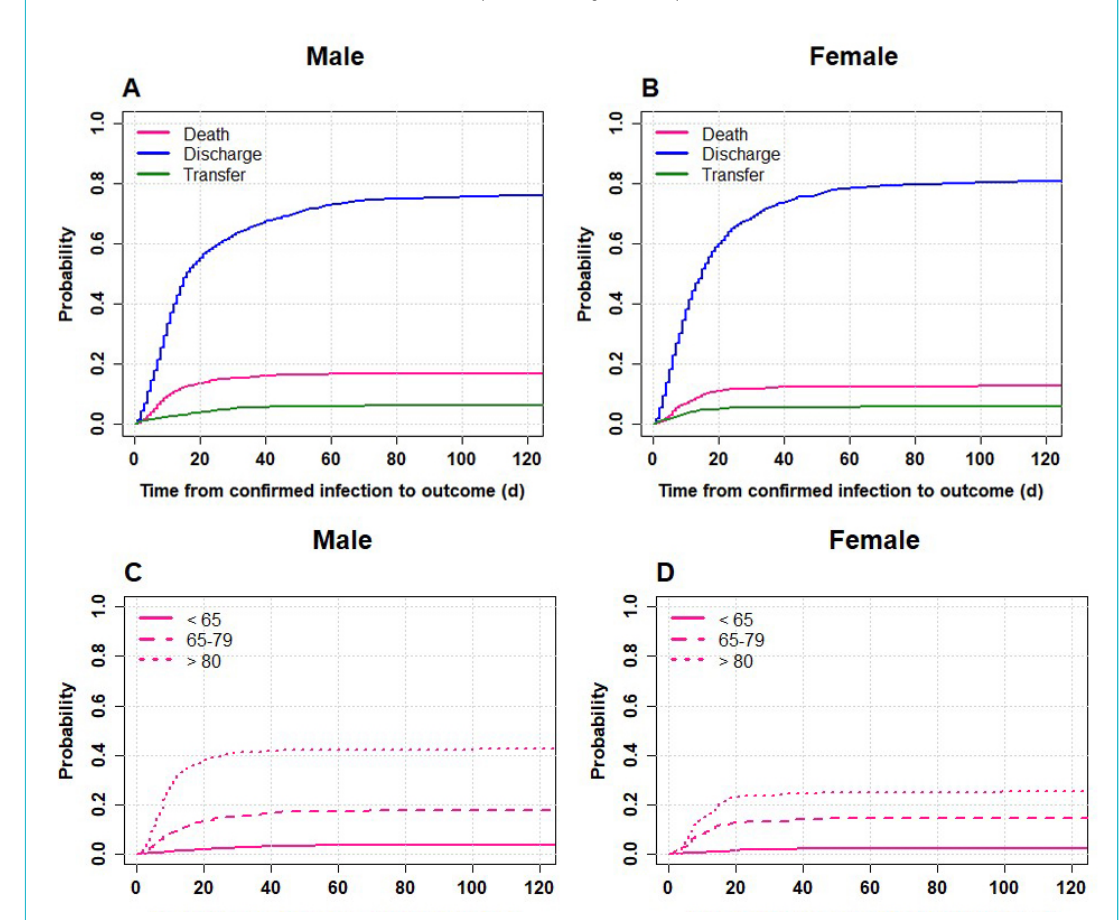
Figure 3: Cumulative distribution functions by gender for 3550 adult patients hospitalised for COVID-19 in Switzerland. Left panels A,C: male patients, right panels B,D: female patients. Panels A,B: all three outcomes – death, discharge and transfer – Panels C,D: outcome death in three age classes. Data included up to 1 September 2020 (date of extraction 15 January 2021). Time to event is defined as the time elapsed from confirmed COVID-19 infection to the event of interest (death, discharge,